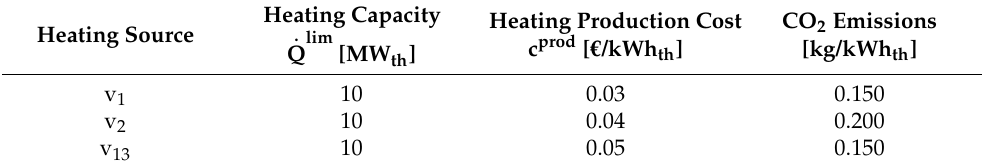
Table 1. Features of the available heating